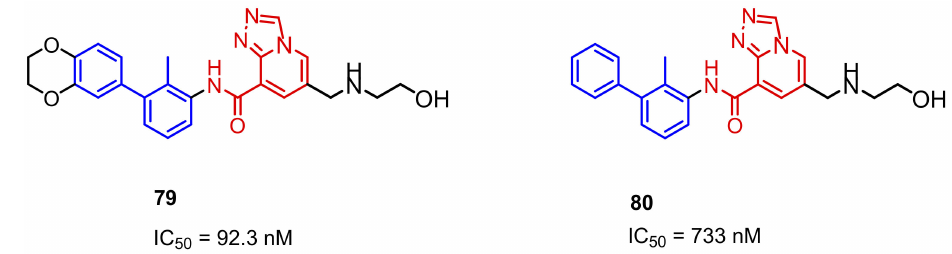
Figure 33. Examples of the compounds published by Qin et al.